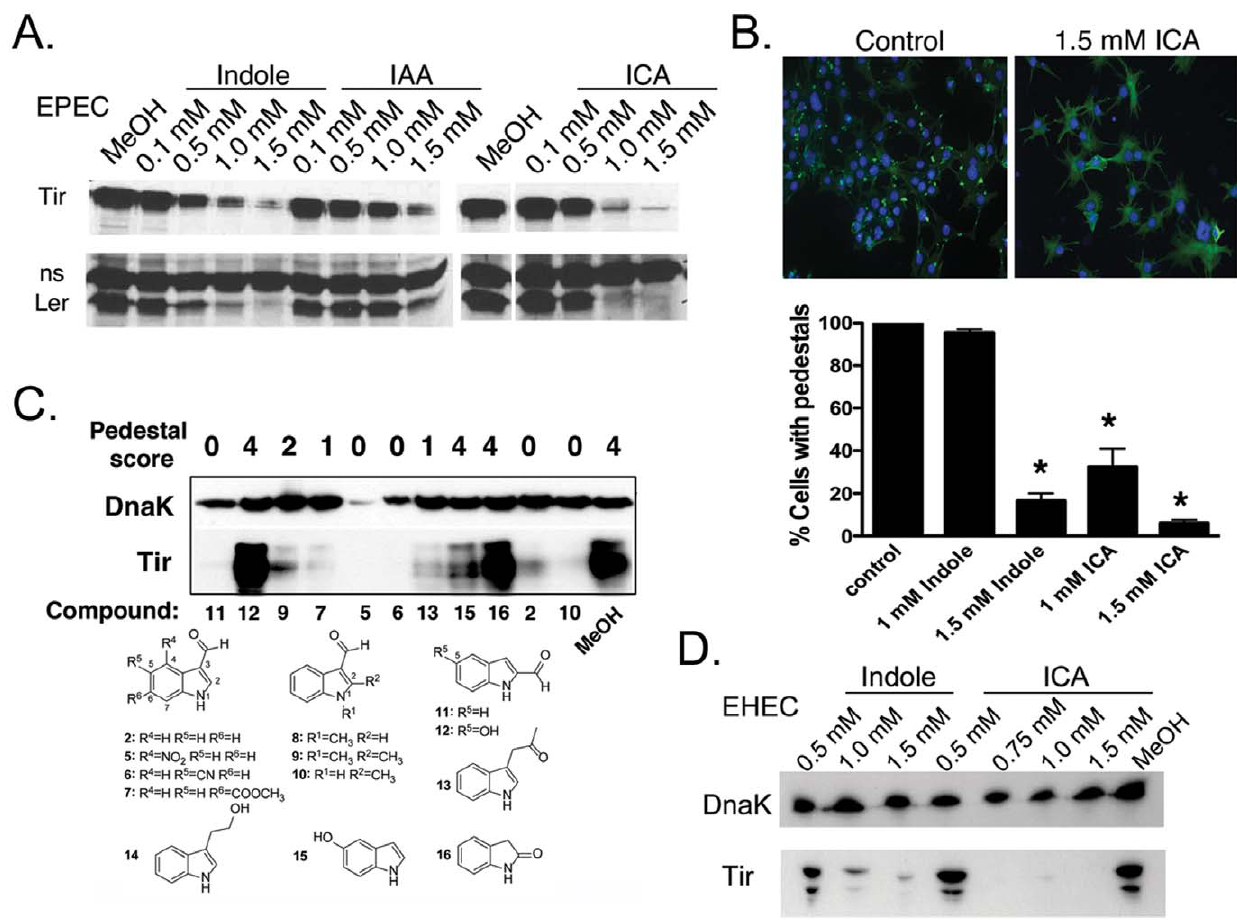
Figure 5. Effects of indole and indole derivatives on LEE gene expression and pedestals. ( a ) Western analysis of Tir and Ler expression in EPEC treated with various concentrations of indole, ICA or IAA. The non-specific band recognized by the Ler pAb served as a loading control. In some experiments, DnaK pAb was used as a loading control and gave identical results (see Fig. S4a). ( b ) Above . Images of 3T3 cells infected for 5 hours with EPEC and treated with 1.5 mM ICA or left untreated. Cells were stained with FITC Phalloidin to recognize actin and DAPI to recognize DNA. At this magnification, pedestals are seen as bright green ‘‘dots.’’ Magnification 200 6 . Below . Quantitation of pedestal formation in 3T3 cells infected with EPEC in the presence of indole or ICA at various concentrations. Mean + / 2 SEM are shown; * corresponds to p , 0.01 with respect to untreated control. ( c ) Western analysis of Tir and DnaK expression in EPEC treated with various synthetic indole derivatives each at 1.5 mM. High Tir levels correlated with pedestal formation, and low DnaK levels correlated with slower growth. Pedestal scoring scale ranged from 0 to 4 (0 corresponds to no pedestals and 4 to pedestal formation as in control). Structures and growth curves are presented in Figs. S1 and S4b, respectively. ( d ) Western analysis of Tir expression in EHEC O157:H7, strain EDL933 treated with various concentrations of indole or